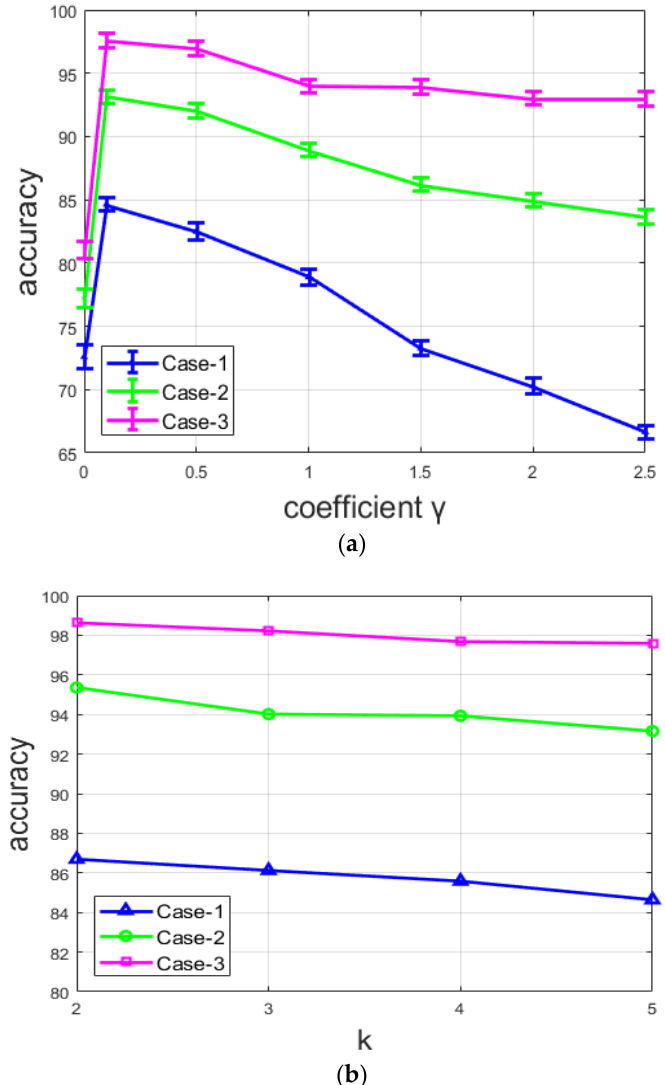
Figure 14. Accuracy of the three networks: ( a ) with different values of coefficient 𝛾 , and ( b ) with different values of k (number of clusters).